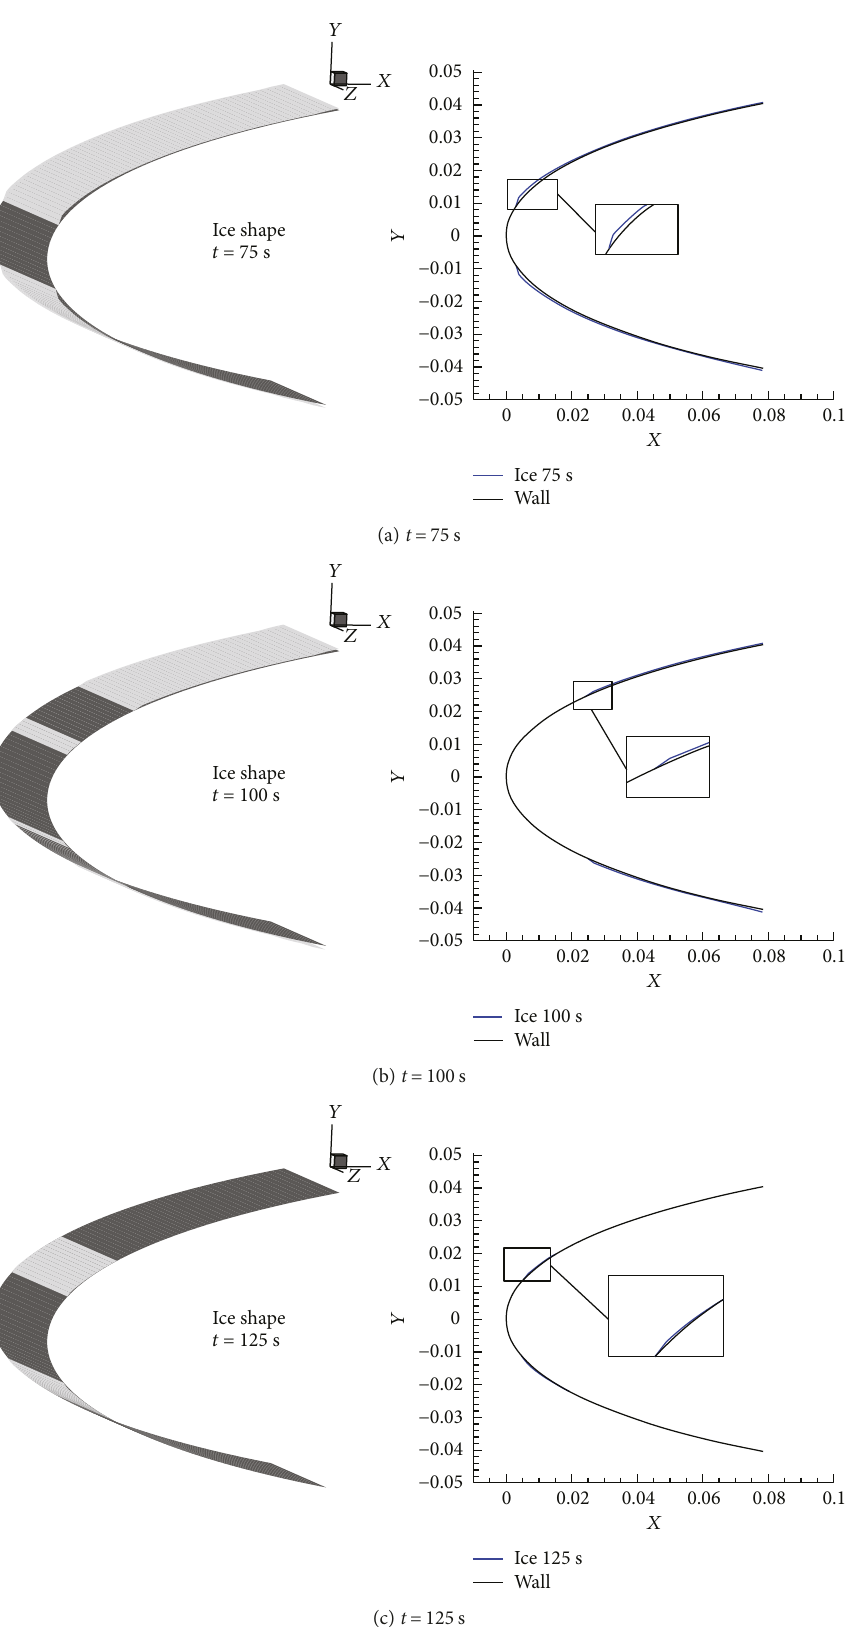
Figure 13: Simulated ice shape of in- fl ight